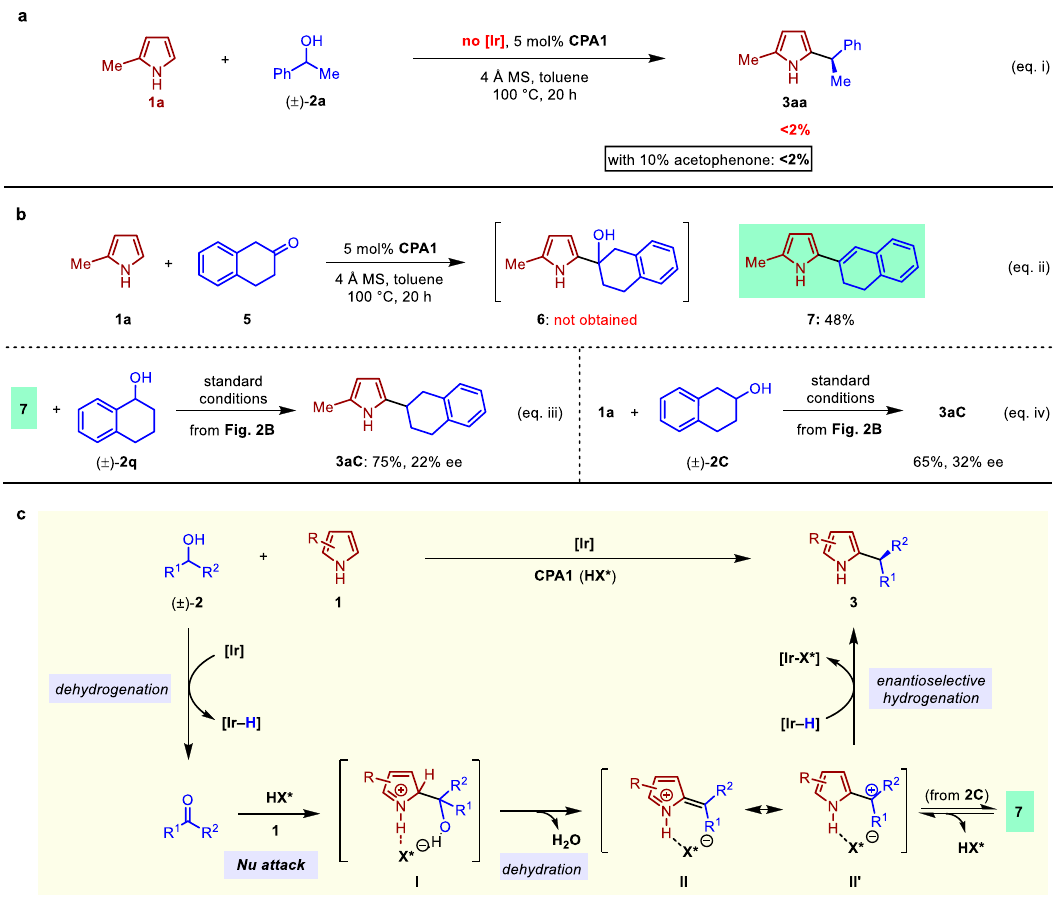
Fig. 5 Mechanistic aspects of enantioconvergent heteroarylation of alcohols. a Con fi rmation of the role of iridium catalyst for enantioconvergent heteroarylation of alcohols. b Isolation and investigation of 9 as an off-cycle isomer of the key carbocation intermediate for enantioconvergent heteroarylation of alcohols. c Proposed catalytic pathway for enantioconvergent heteroarylation of alcohols with